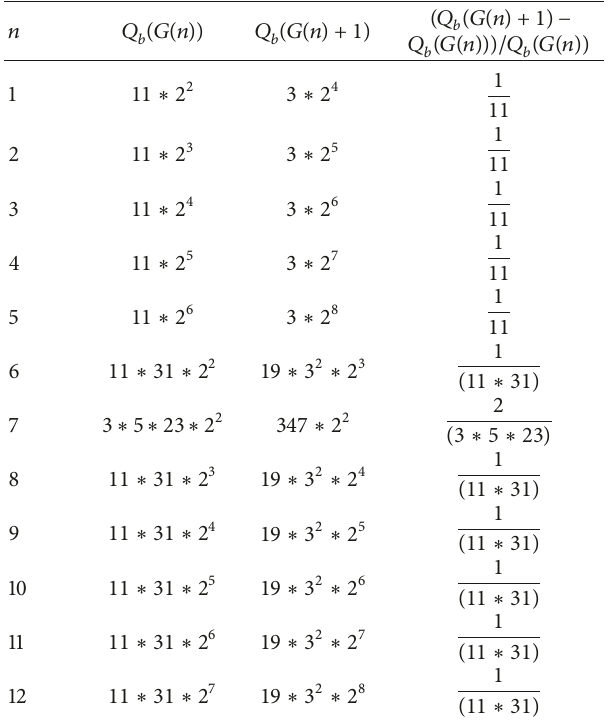
Table5:Hiddenorderthat 𝐺(𝑛) sequenceshowson 𝑄 𝑏 (𝑛)